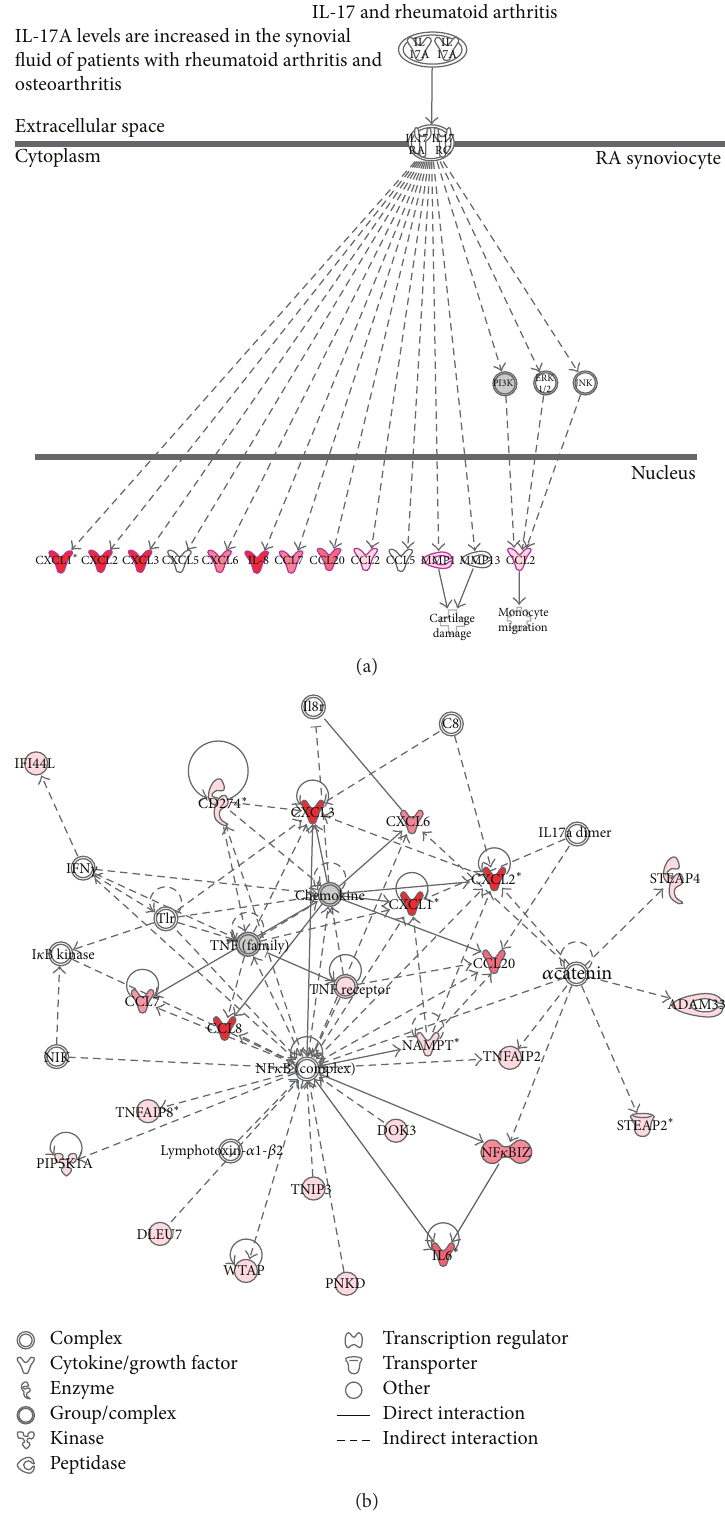
Figure 3: Network of the IL-17A pathway by Ingenuity Pathway Analysis (IPA). Data were analyzed using the Ingenuity Pathway Analysis system (Ingenuity System, http://www.ingenuity.com/). (a) IL-17A-induced genes associated with rheumatoid arthritis. (b) Network 1 of IL- 17A-induced genes by IPA. The intensity of the node color indicates the degree of upregulation (red). Nodes are indicated by various shapes that represent the functional class of the gene product. The lines are displayed with various labels that describe the nature of the relationship between the